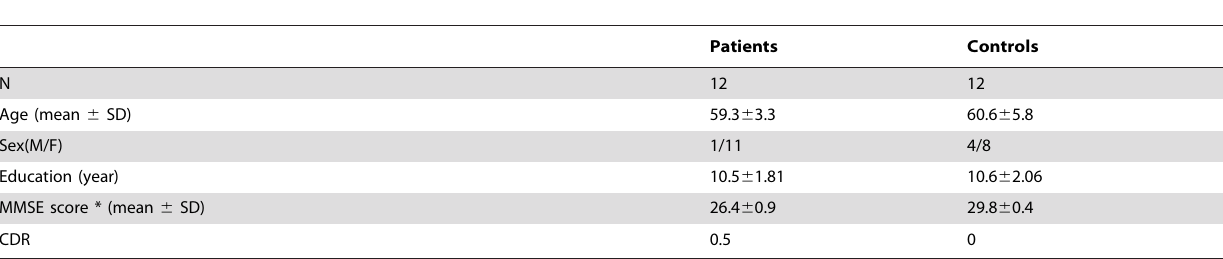
Table 1. Subject characteristics.